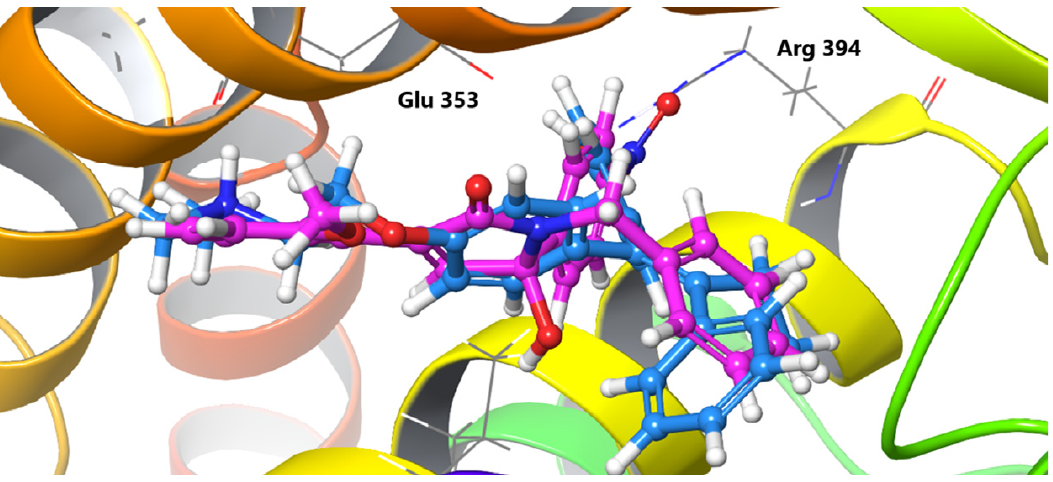
Figure 1. Predicted binding modes of hydroxy-diaryl-1,5-dihydro-2 H -pyrrol-2-one scaffold (Magenta, docking score value: − 8.75 kcal/mol) into the binding site of ER α and superimposed on the crystal structure of 4-hydroxy-tamoxifen (blue, PDB 3ERT).